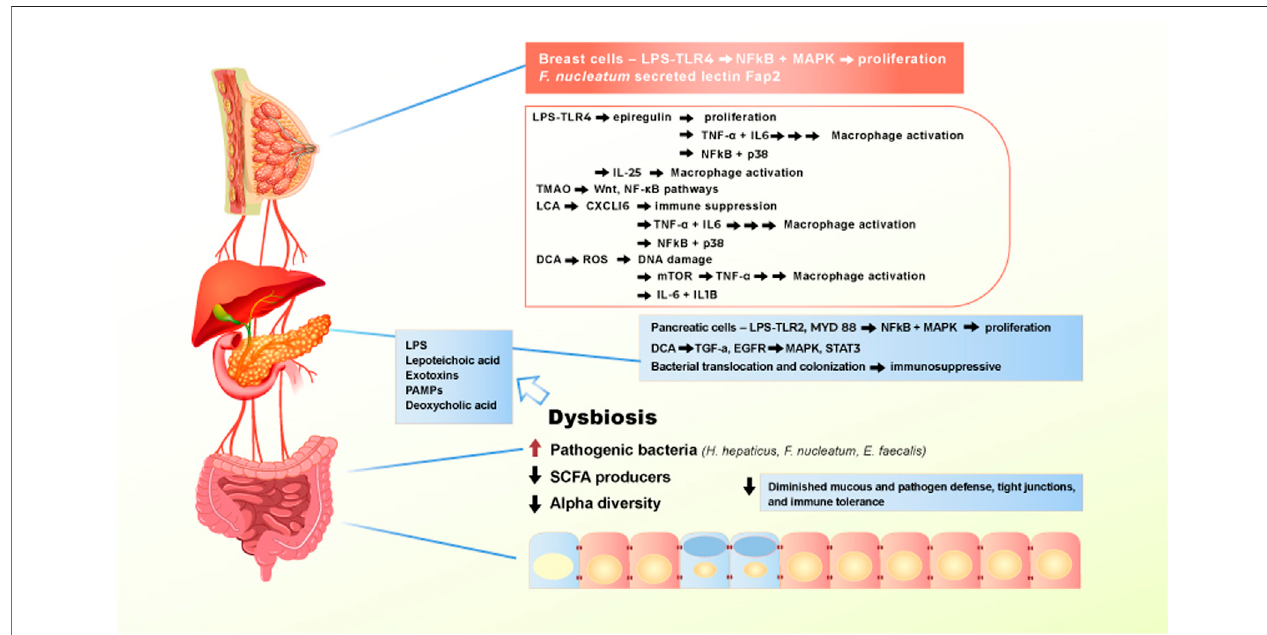
FIGURE3| Effect ofWesterndieton thegut microbiome and extraintestinalpro-carcinogenic pathways. Adherence toWesterndietpromote theestablishmentof chronic dysbiosis in the gut, leading to translocation of pathogenic bacteria and toxic bacterial metabolites entering systemic circulation and reaching extraintestinal organs. Main drivers of the pro-carcinogenic and pro-in fl ammatory processes are LPS, lipoteichoic acid, numerous exotoxins, PAMPs, and deoxycholic acid. When bacterial metabolites reach liver, pancreas, and breast, they bind to receptors, such as TLR4 to activate signaling pathways that drives in fl ammation and